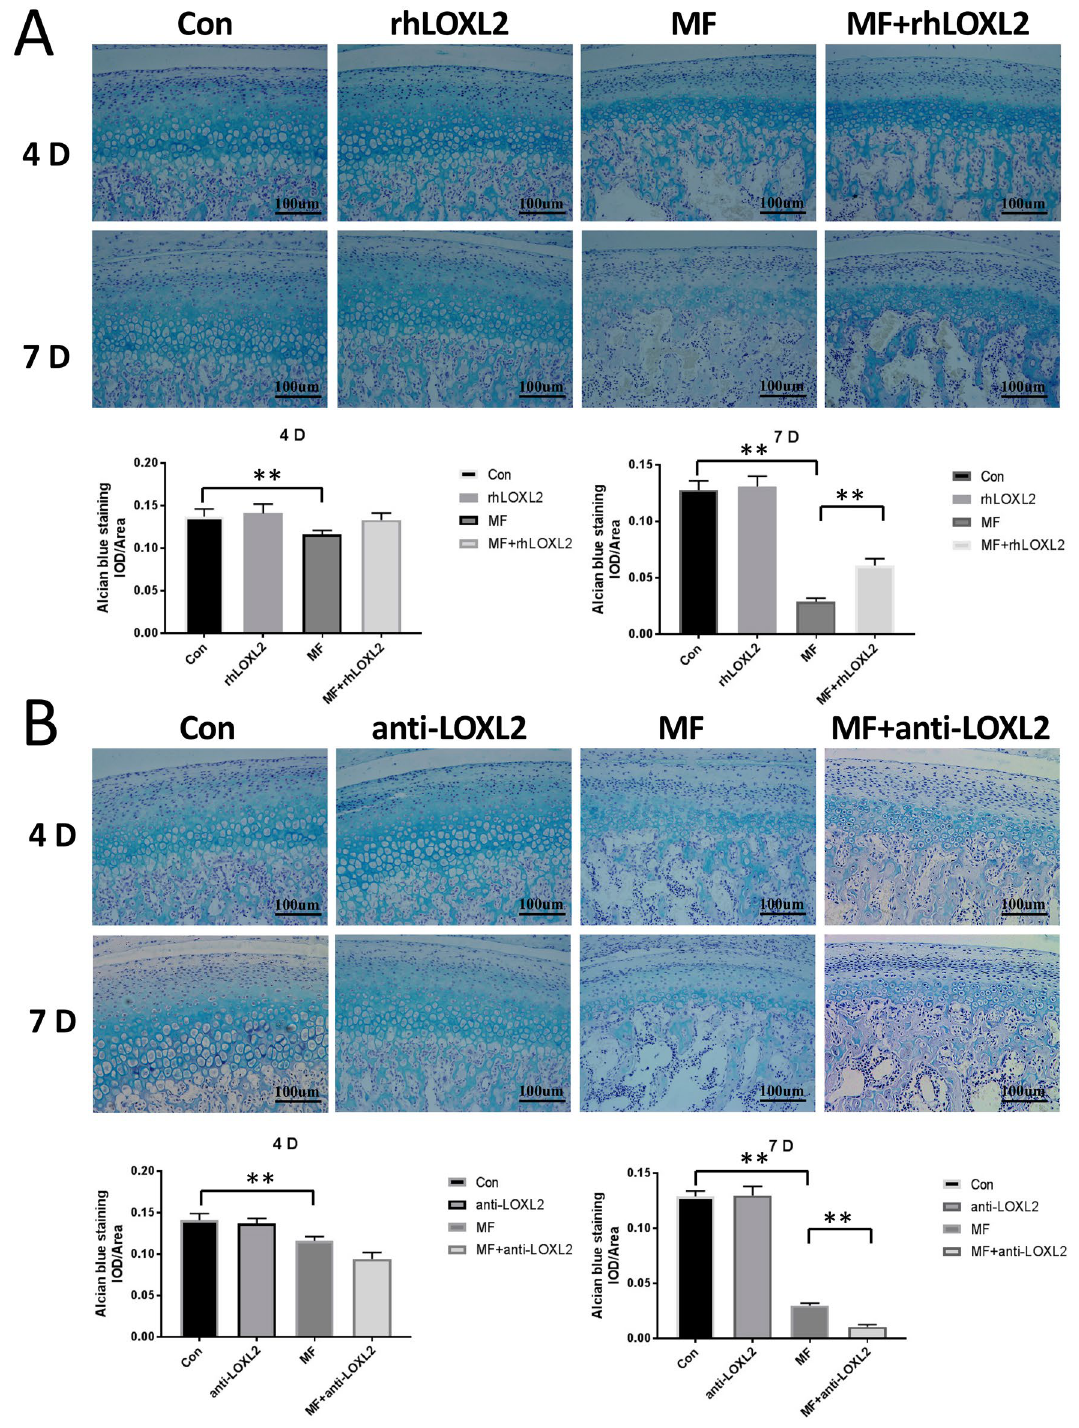
Figure 3. LOXL2 restored ECM degradation in mandibular condyle cartilage at 4 and 7 d after force application. Alcian blue-stained cartilage sections were treated as indicated (n = 12). ( A ) Degradation of proteoglycan in F groups was recovered by rhLOXL2, ( B ) while worsened by anti-LOXL2. Quantification was listed below (n = 12). *P < 0.05, **P <